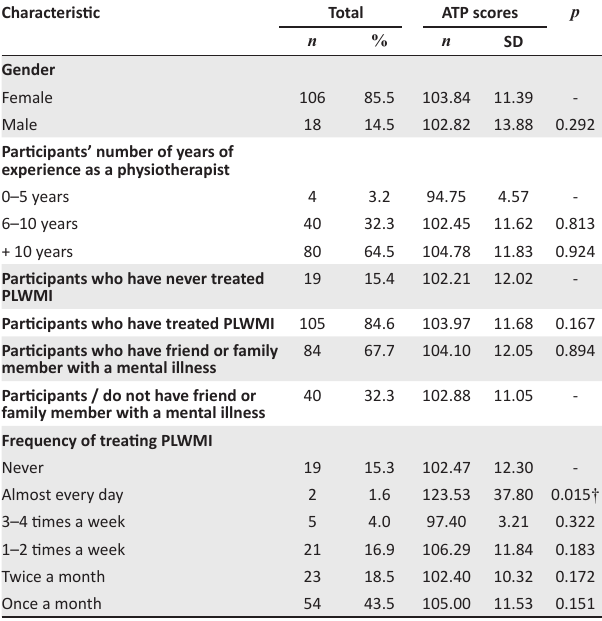
TABLE 1: Selected participant characteristics and their influence on the Attitudes to Psychiatry-30 scores by using a linear regression model.